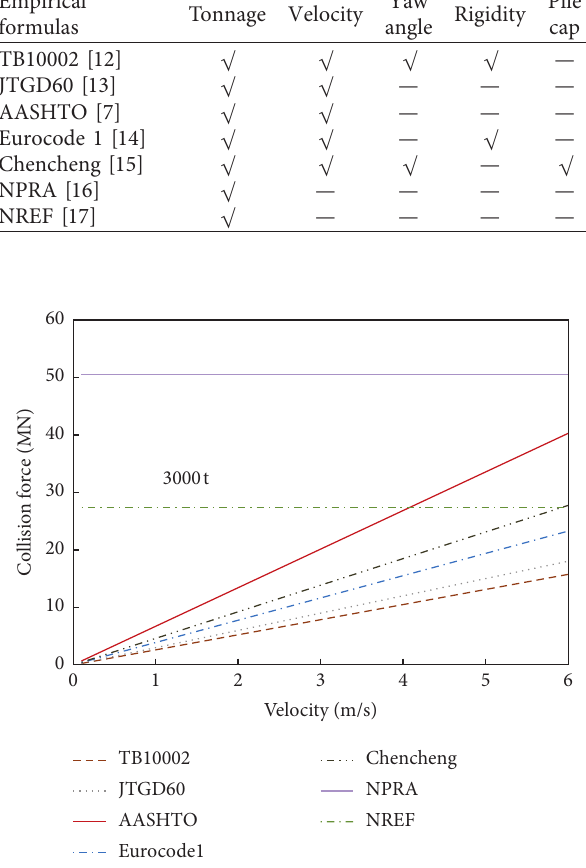
Figure 4: Comparison of relationship between ship impact force and ship impact velocity for various models.